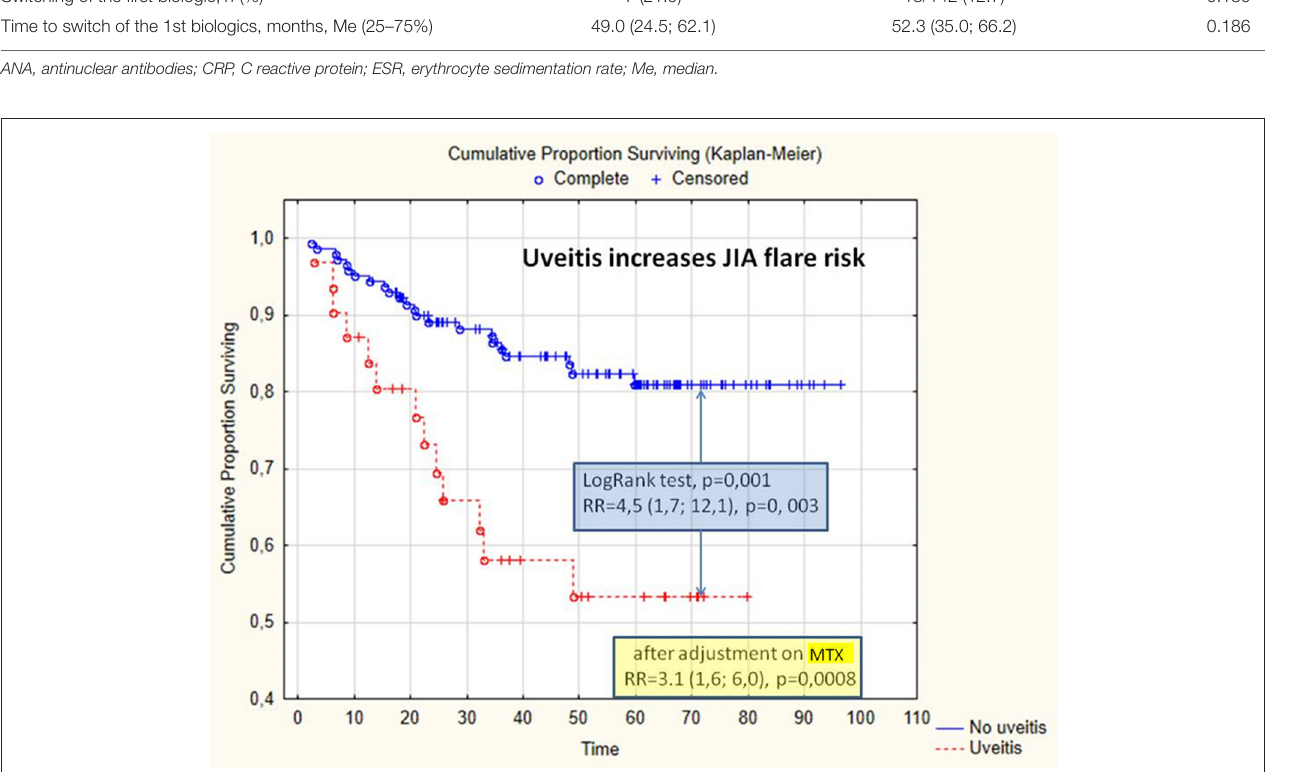
= 4.5 (95% CI: 1.7; 12.1), p = 0.003; log-rank test, p = 0.001 ( Figure 1 ). After adjusting methotrexate treatment, uveitis is a risk factor in arthritis flare, RR = 3.1